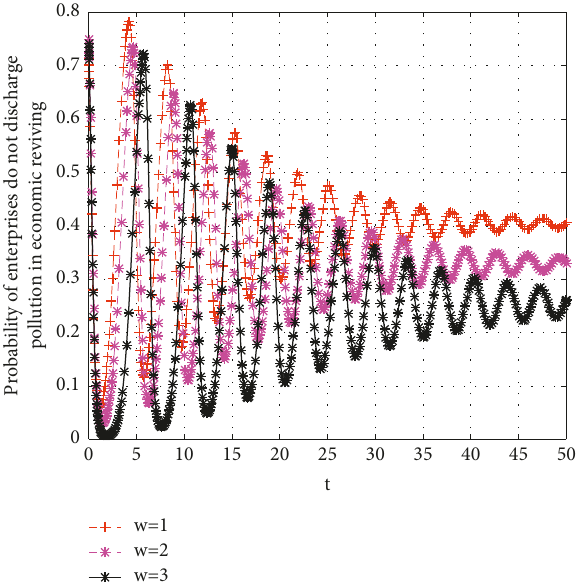
Figure 12: The evolution path of enterprises’ nondischarge when government financial support increases under the dynamic in- centives mechanism and penalties mechanism.